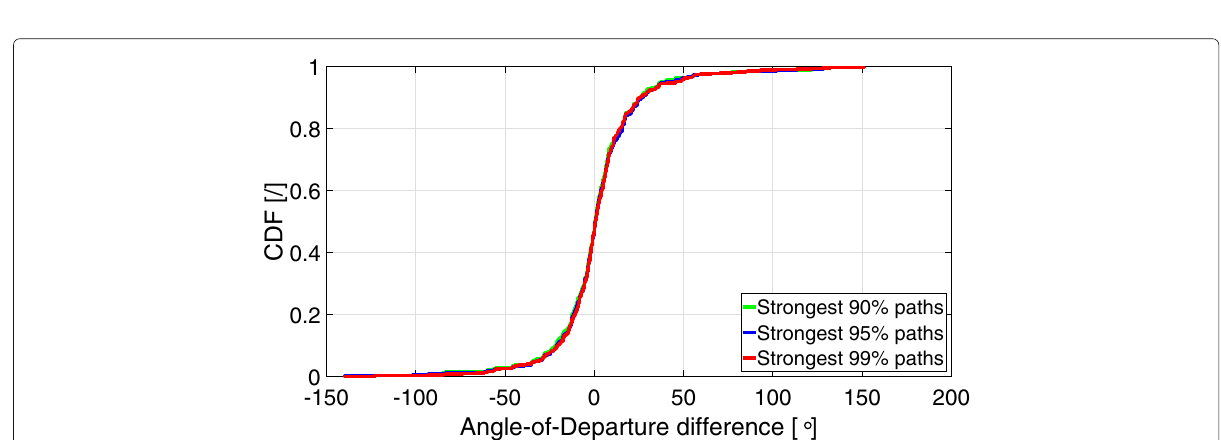
Fig. 5 CDF of AoD differences between the input and output strongest 90, 95, and 99% propagation